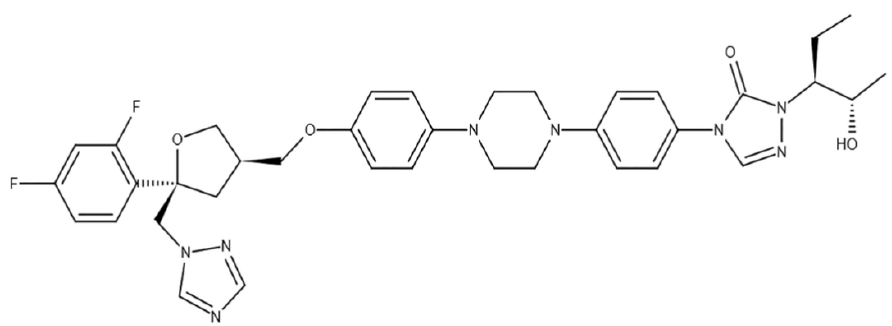
Figure 3. Chemical structure representing Posaconazole.